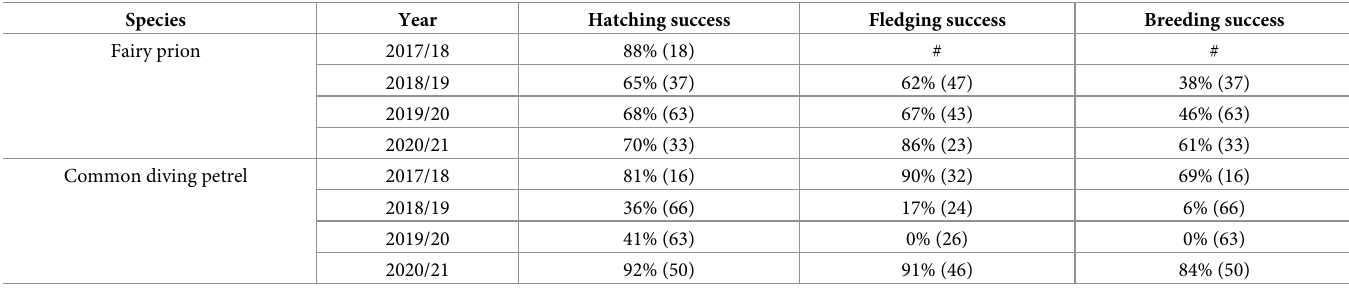
Table 2. Hatching, fledging and breeding success (mean ± SE) of fairy prions ( Pachyptila turtur ) and common diving petrels ( Pelecanoides urinatrix ) from Kanowna Island, Bass Strait, south-eastern Australia. Sample sizes are provided in parentheses. Species Fairy